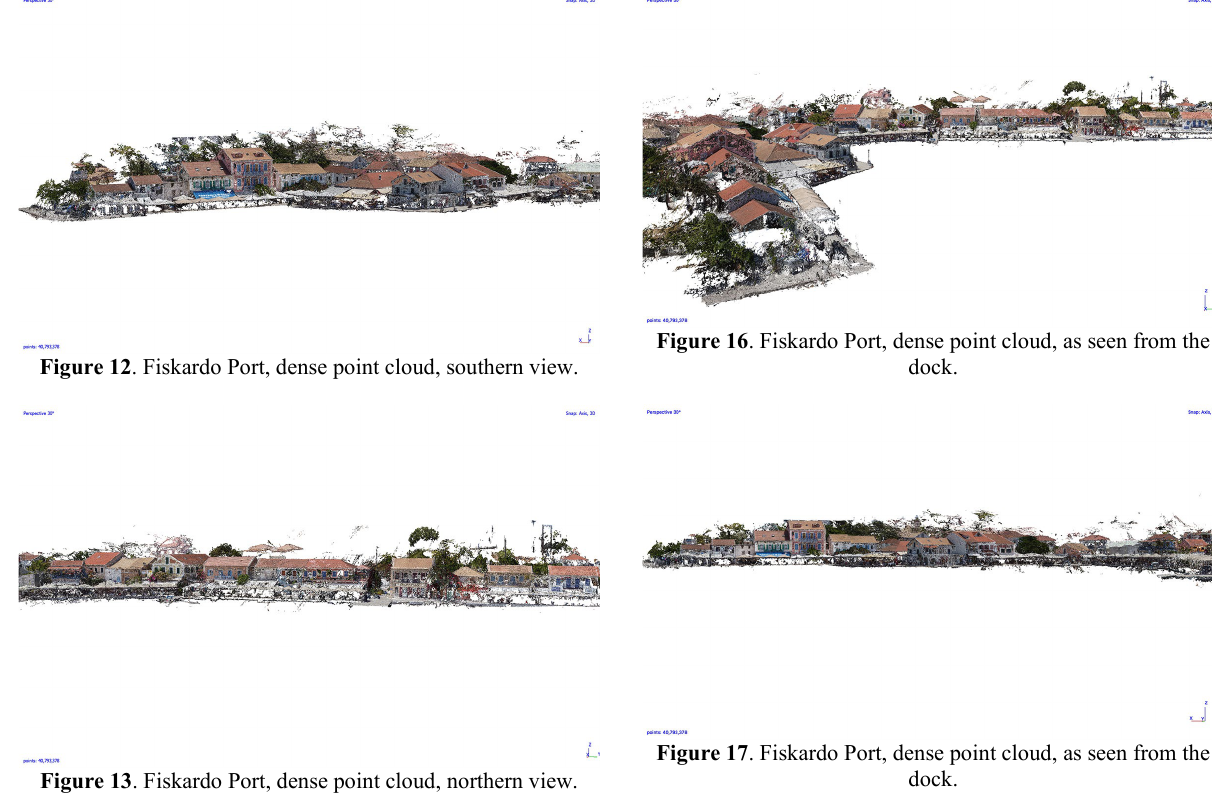
Figure 13 . Fiskardo Port, dense point cloud, northern view.